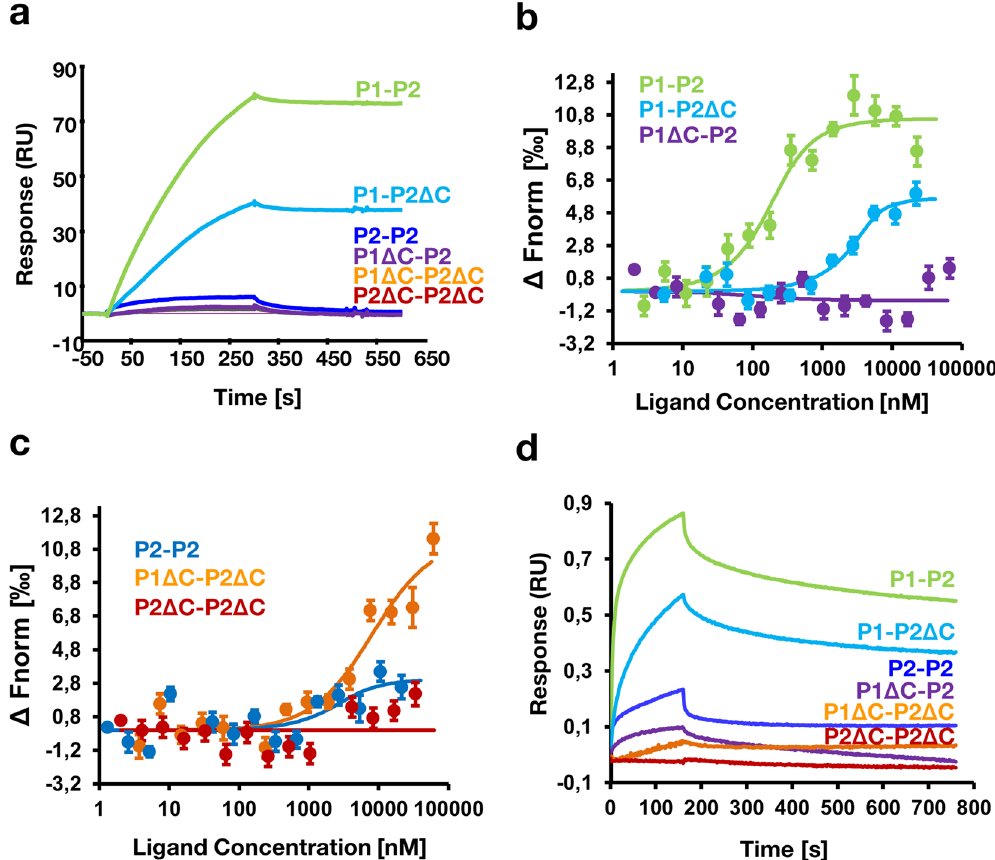
Figure 2. Interaction of RTA with human ribosomal stalk P1-P2 complexes. ( a ) Interaction of RTA with different forms of human P1-P2 dimers measured with surface plasmon resonance (SPR). Interaction was analyzed using Biacore T200. The His-tagged RTA was immobilized on the Ni 2 + –nitrilotriacetic acid (NTA) sensor chip as the ligand and the human P1-P2 complexes were used as an analyte. P1-P2 dimers (50 nM) were passed over the immobilized RTA at 50 µ L/min for 5 min and dissociation was measured for 3 min. ( b ) Microscale thermophoresis (MST) binding curves for the P1-P2, P1-P2 Δ C and P1 Δ C-P2 complexes with RTA. (c) MST binding curves for the P2-P2, P2 Δ C-P2 Δ C and P1 Δ C-P2 Δ C and RTA. Δ Fnorm values were centered for every curve at 0. Error bars ± SE ( n = 3). ( d ) Interaction of RTA with human ribosomal stalk P1-P2 complexes measured with bio-layer interferometry (BLI). Interaction was analyzed using OCTET 96 RED with NTA chip sensors. Representative association/dissociation curves are shown for the dimeric complexes at 112 nM. Data are plotted as means of three